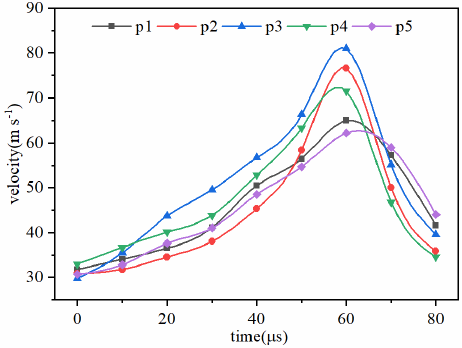
Figure 9. Instantaneous velocity curves of five particles.